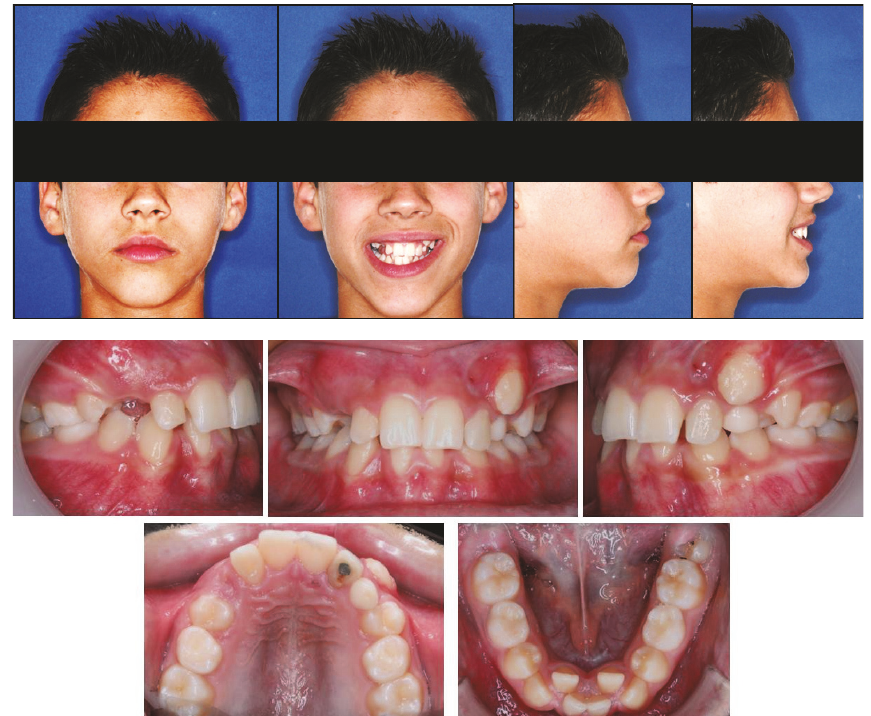
Figure 1: Initial diagnostic